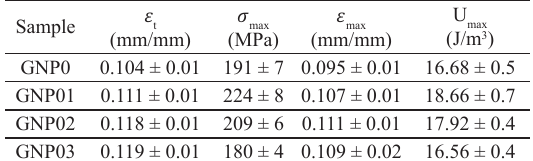
Table 2. Split Hopkinson pressure bar dynamic results: mean deformation ( ), maximum average stress ( t 𝜀